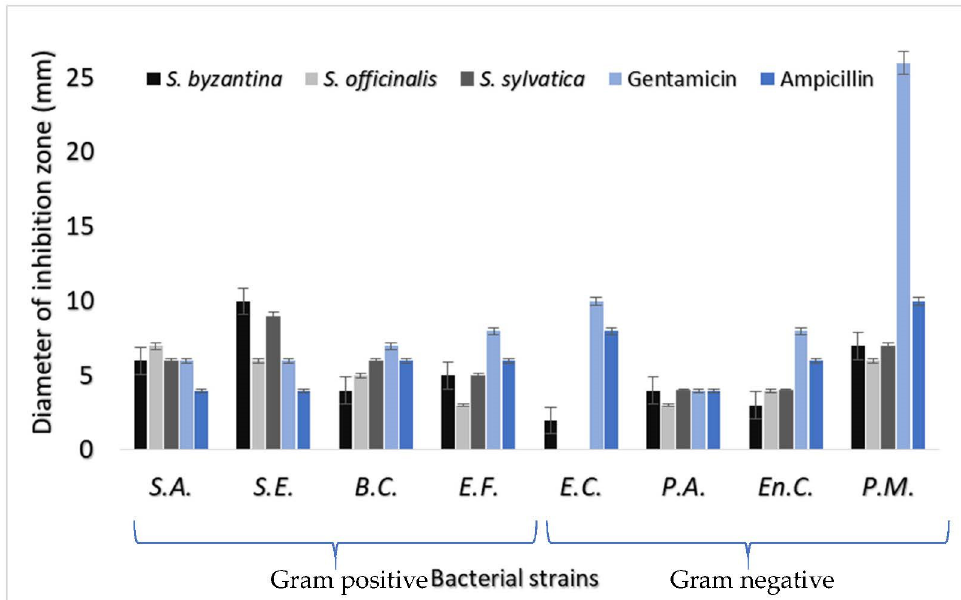
Figure 2. Antibacterial activity of Stachys byzantina , S. officinalis and S. sylvatica extracts on S.A.: Staphylococcus aureus (ATCC 25923), S.E.: Staphylococcus epidermidis (ATCC 12228), B.C.: Bacillus cereus (ATCC 9372), E.F.: Enterococcus faecalis (ATCC 19433), E.C.: Escherichia coli (ATCC 8739), P.A.: Pseudomonas aeruginosa (ATCC 10145), En.C.: Enterobacter cloacae (ATCC 43560), P.M.: Proteus mirabilis (ATCC 29906).